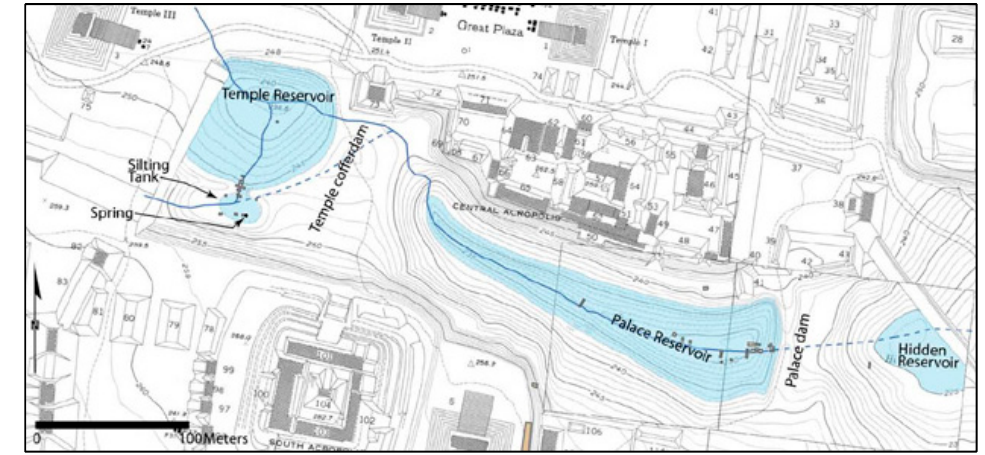
Figure 8. Map of Tikal’s central reservoirs (adapted from [56]).